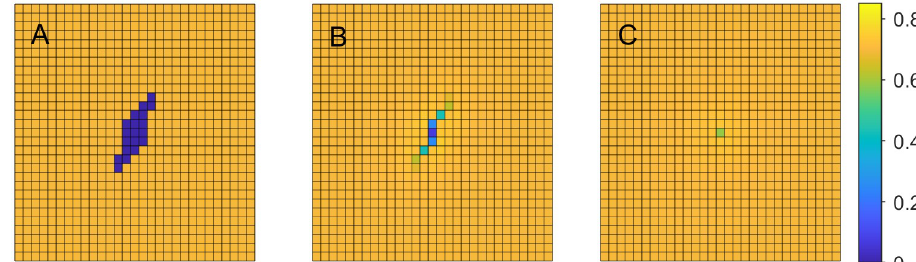
Fig 2. Tissue regeneration. Cellular volume fraction u 1 at time steps t = 1, 11, 21 with b 1,max = 0.04. A: time step t = 1, B: time step t = 11, C: time step t = 21.